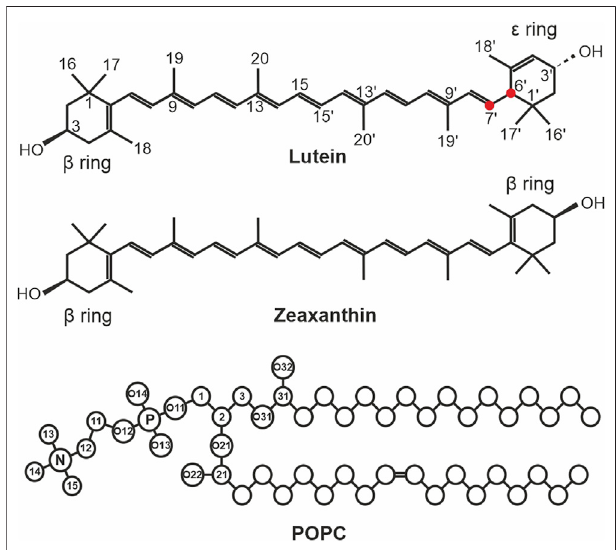
FIGURE 1 | The chemical structures of lutein, zeaxanthin, and 3- palmitoyl-2-oleoyl-1-phosphatidyl-choline (POPC). The ionone rings and atoms that are used in the analyses are indicated in lutein only. The C6 ′ and C7 ′ atoms of lutein are indicated with red circles. The XAN atoms in the scheme are numbered according to the IUPAC convention (Nomenclature, I.C.o.t.N.o.O.C.a.t.I.-I.C.o.B., 1975). In POPC, the head group atoms are numbered in accordance with Sundaralingam (Sundaralingam, 1972). The numbers of the atoms of the acyl chains, the chemical symbols for carbon atoms, C, and the hydrogen atoms have been omitted except for the OH groups of lutein and